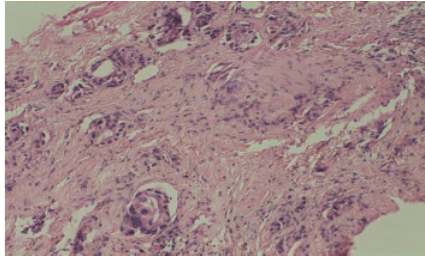
Figure 1: Irregular tumoral adenoid structures located inside fibroblastic stroma of prostate (hematoxylin-eosin cross section at 20 × 10 magnification).